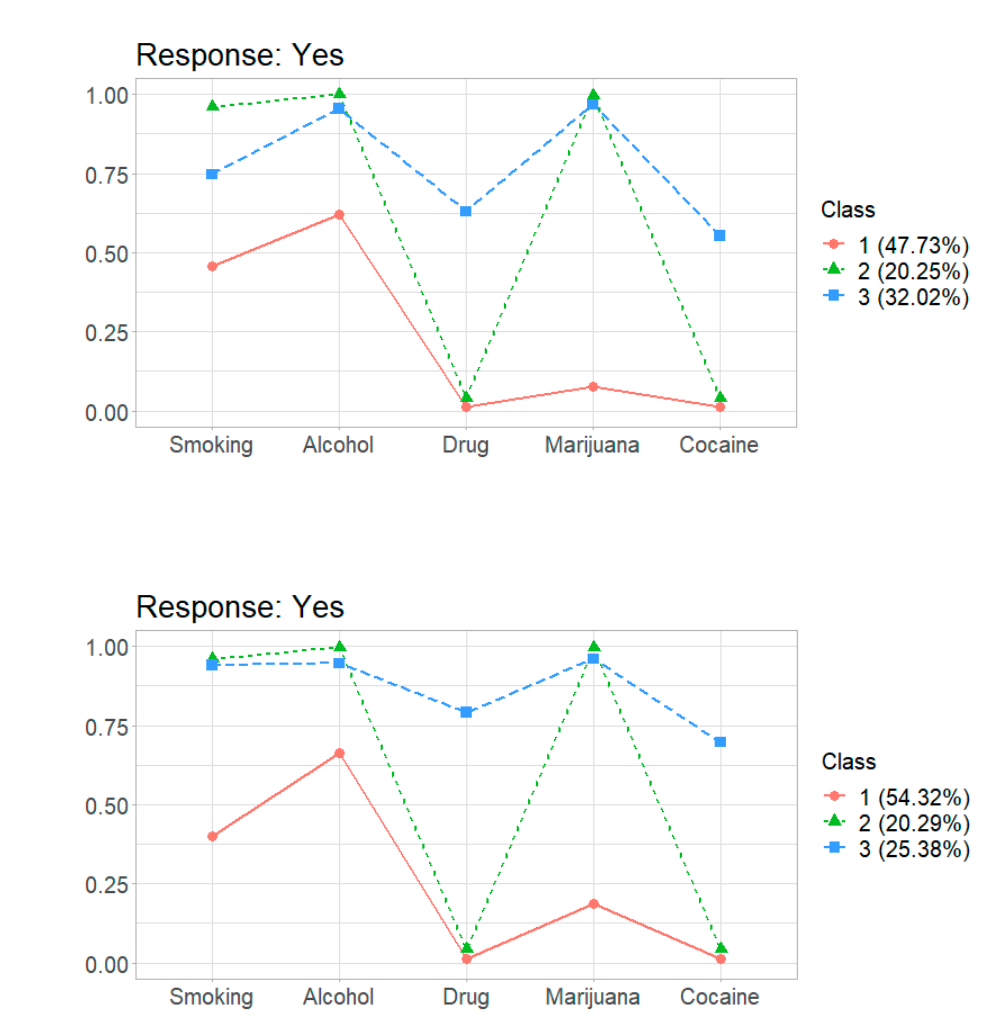
Figure 3. Item response probabilities of Model 1 and Model 2. Model 1: no adding covariates in GSCA model; Model 2: adding the gender covariate in GSCA model. Class 1: smoking and drinking; Class 2: binge drinking and heavy smoking; Class 3: heavy substance abuse.